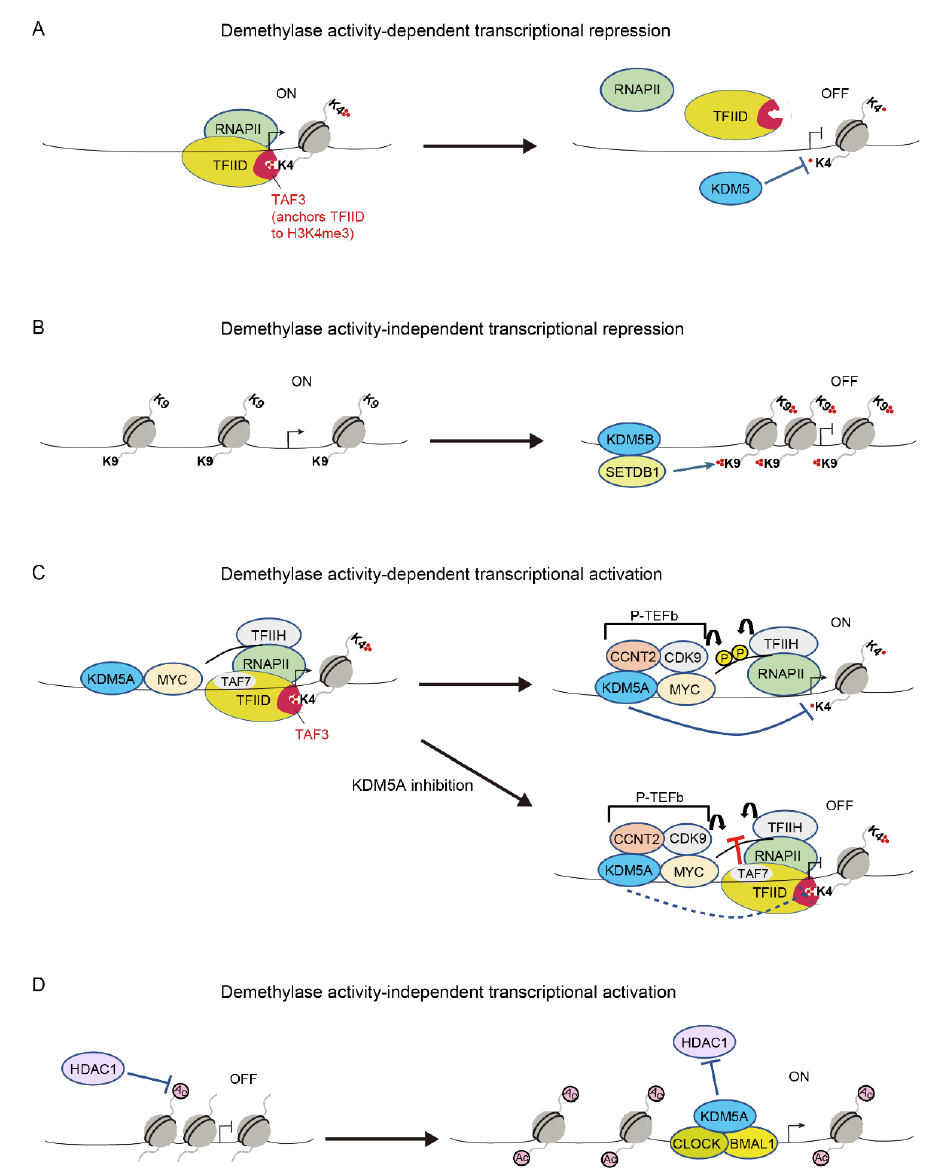
Figure 2. Transcriptional regulation by KDM5. ( A ) Pre-initiation complex assembly is mediated by the selective anchoring of the basal transcription factor TFIID to the core promoter via TAF3 binding to H3K4me3. KDM5 proteins remove H3K4me3, thereby preventing transcription. ( B ) KDM5B functions as a scaffold protein and recruits the H3K9 methyltransferase, SETDB1, thereby suppressing retroelement expression by adding H3K9me3 [44]. ( C ) After pre-initiation complex formation, KDM5A supports the transcription of MYC target genes via the timely removal of H3K4me3, thereby allowing for the release of TFIID and for the phosphorylation of RNA polymerase II (RNAPII). KDM5A inhibition blocks H3K4me3 demethylation, thereby locking TFIID via TAF3 anchoring and impairing the activities of TFIIH and P-TEFb, which may be mediated by TAF7 [35] . ( D ) KDM5A promotes CLOCK – BMAL1-mediated transcription by inhibiting HDAC1 [52] .